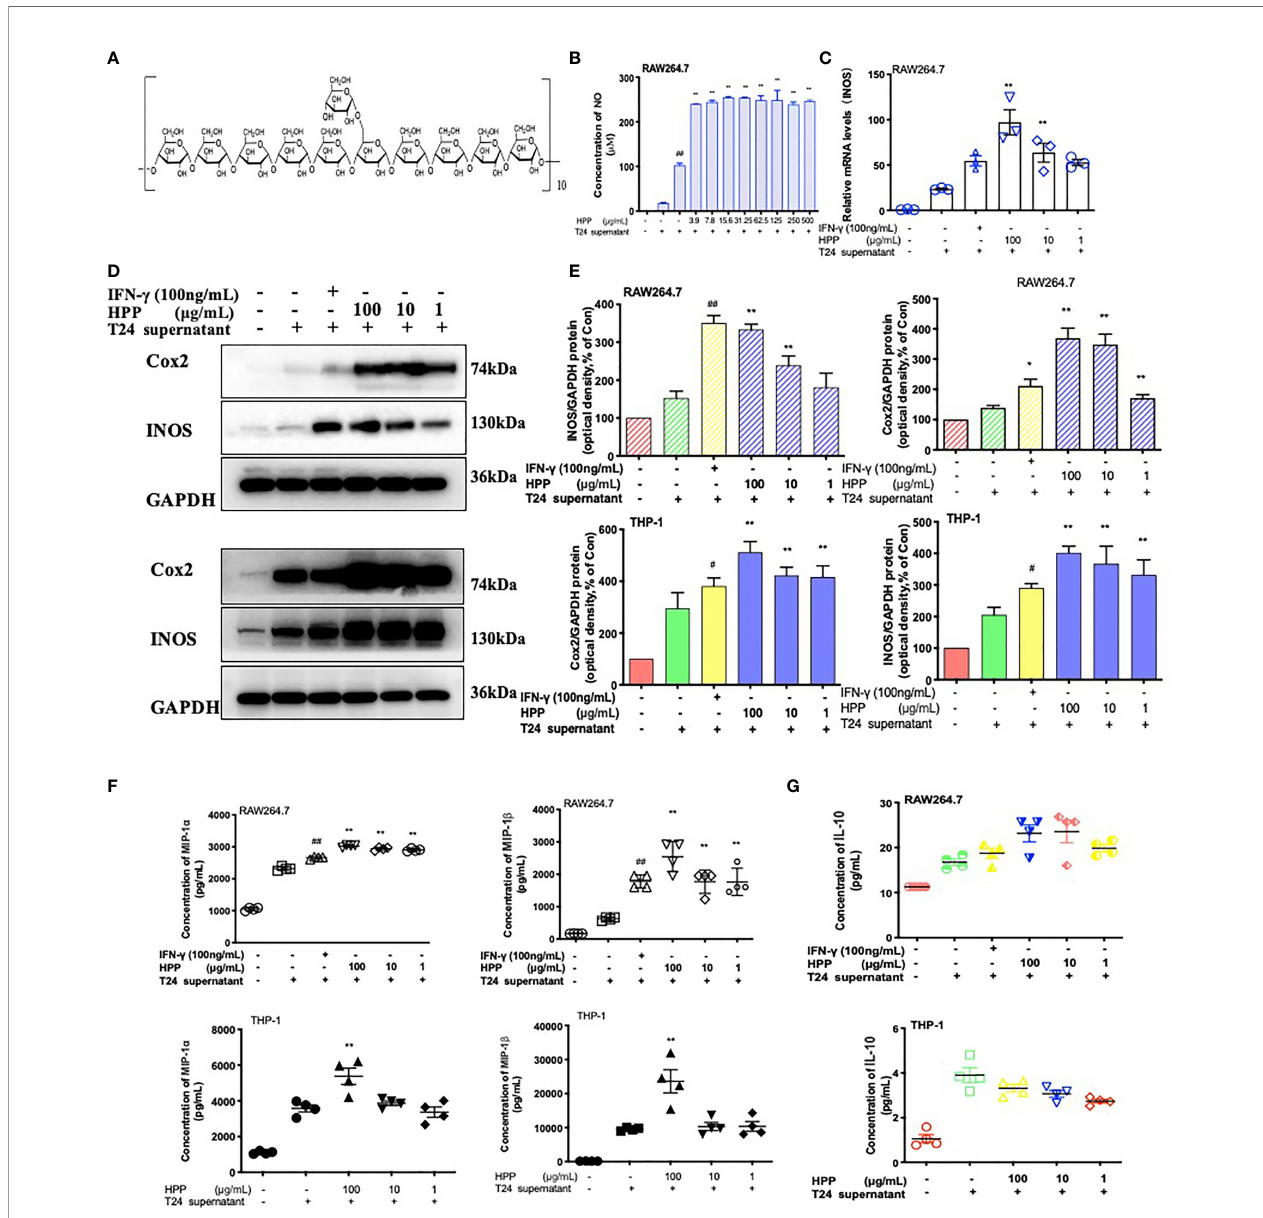
FIGURE 4 | Con fi guration of HPP and the activation of macrophages. (A) Con fi guration of HPP. (B) NO secretion in macrophages treated with HPP. (C) The expression of iNOS mRNA in macrophages stimulated by HPP. (D, E) The expression of iNOS and Cox2 in macrophages stimulated by HPP. (F) The secretion of MIP-1 a and MIP-1 b in macrophages treated with HPP. (G) The secretion of IL-10 in macrophages treated with HPP. Values are given as the mean ± SD from three independent experiments. Compared with the control group, # P < 0.05; compared with the RAW 264.7+T24 group, * P <